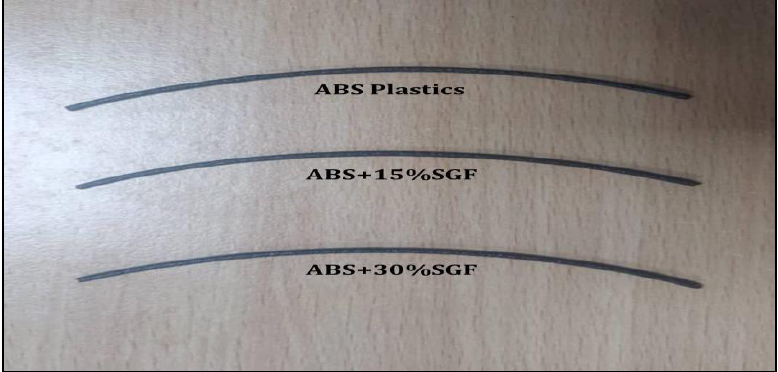
Figure 4. Photograph of ABS and ABS + SGF filament developed by twin screw extrusion.